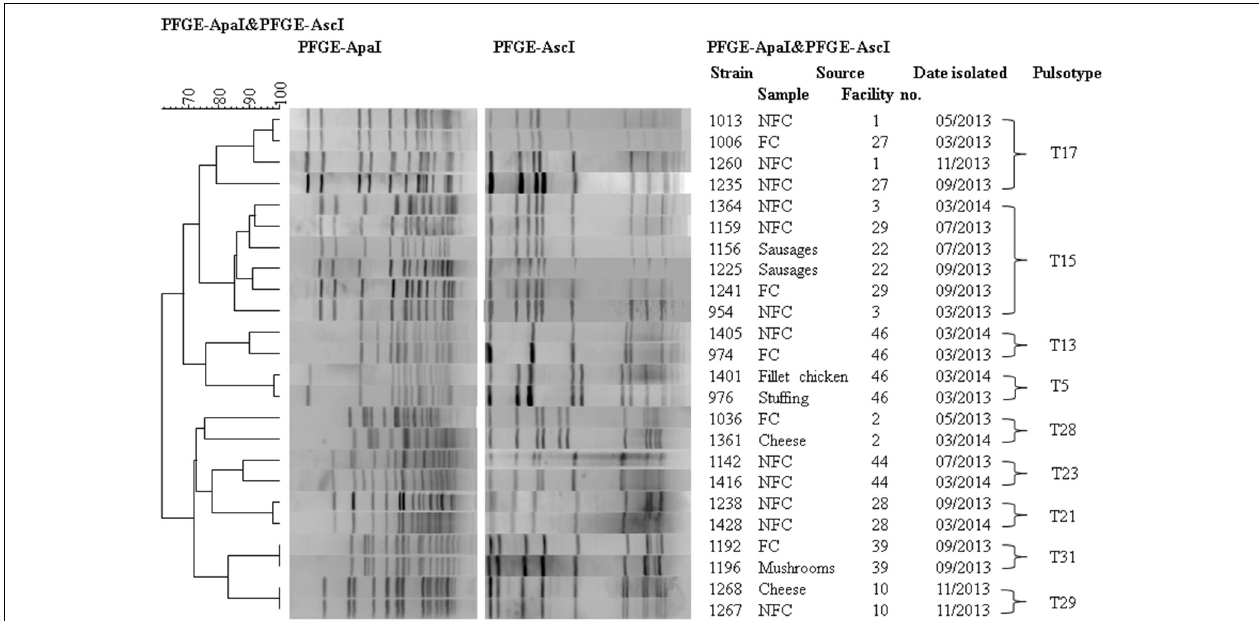
FIGURE 3 | Dendrogram of PFGE pulsotypes which persisted for over 6 months or were isolated from both food and environment samples within the same facility. Examples of interest from each pulsotype are shown. FC, Food contact; NFC, Non-food